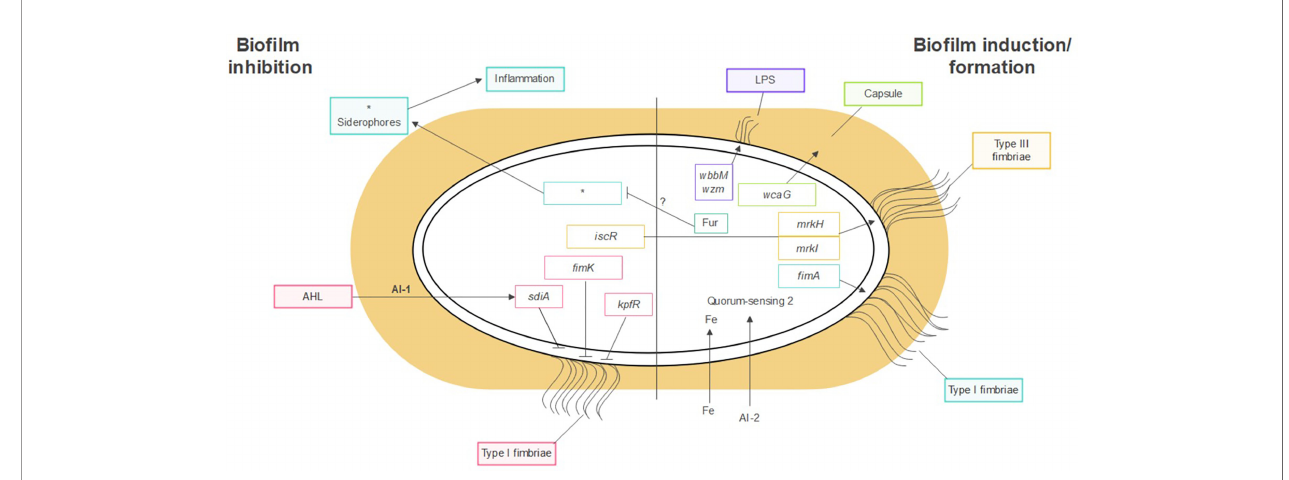
FIGURE 1 | Factors contributing to K. pneumoniae bio fi lm formation. Polysaccharide capsule, LPS, fi mbriae, pili, iron metabolism and, quorum sensing. *Molecules related to